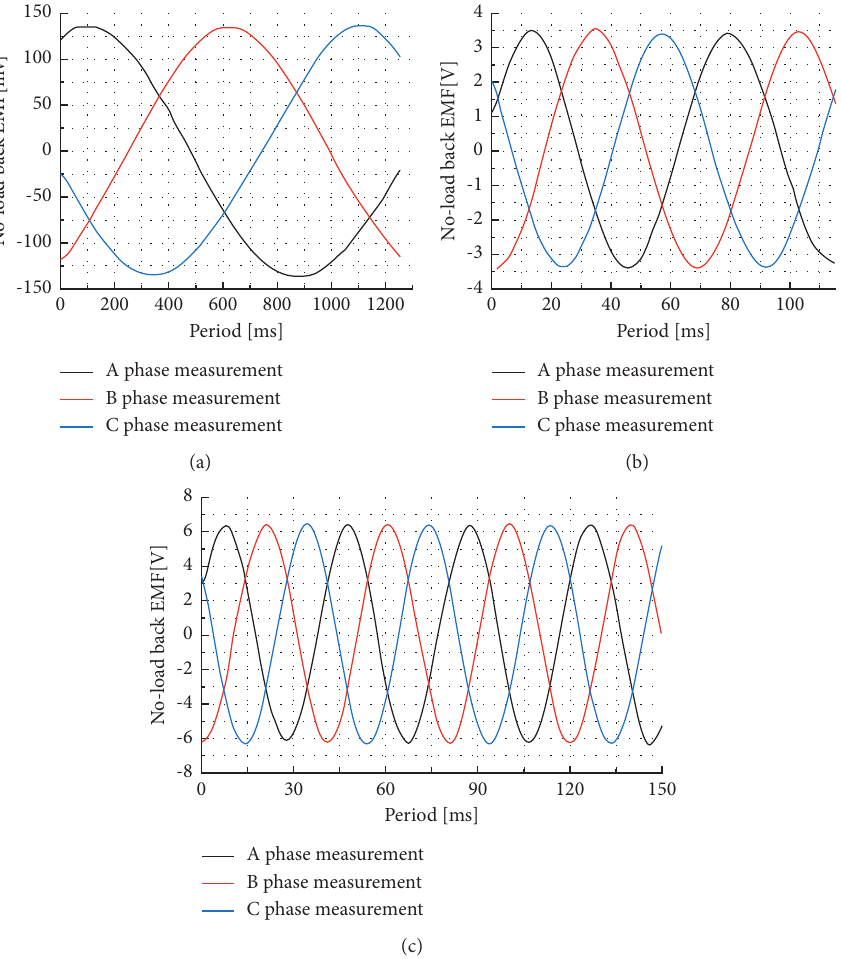
Figure 22: Oscillograph at different speeds: (a) v � 0.02m/s; (b) v � 0.6 m/s; (c) v �